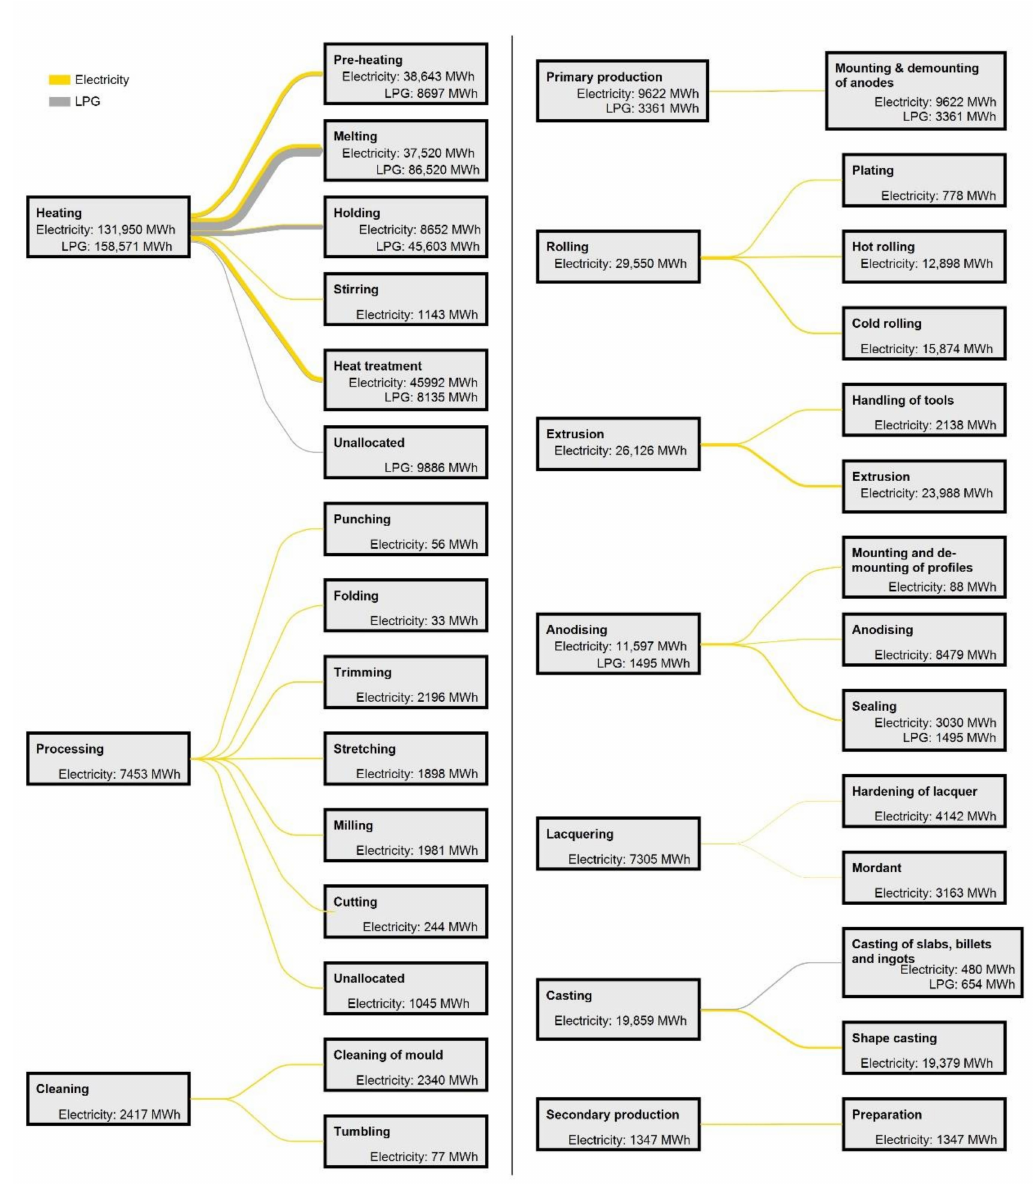
Figure 12. The energy end-use of the aluminium industry and two aluminium casting foundries in Sweden for the main categories within the production processes, divided into the processes included within each category. Electrolysis is excluded. Processes occurring at several companies in the supply chain have been combined into one entry